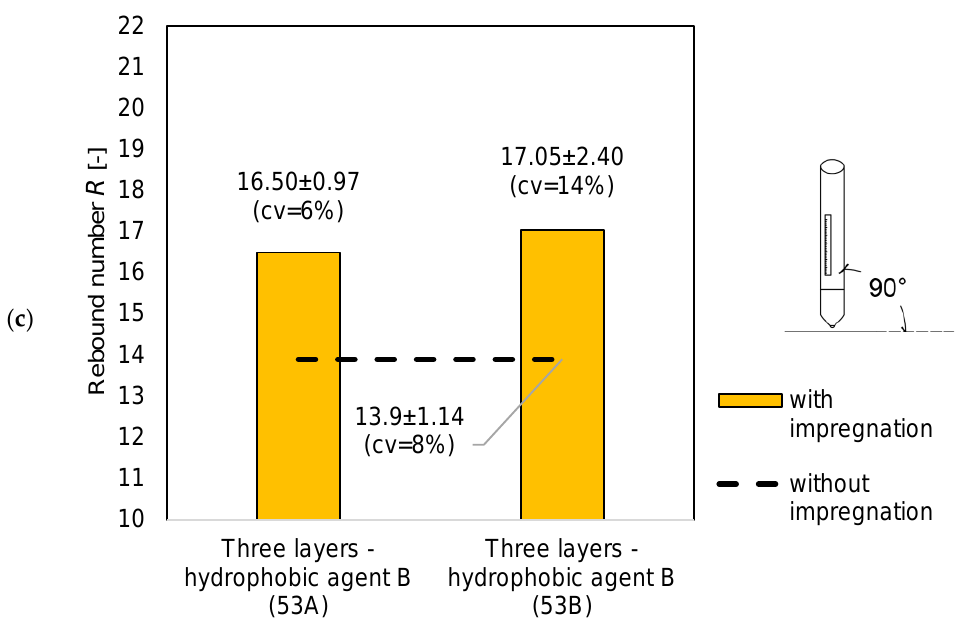
Figure 4. Comparison of the average rebound number for the samples with w/c = 0.5: ( a ) without impregnation and with one layer of the hydrophobic agent; ( b ) without impregnation and with two layers of the hydrophobic agent; and ( c ) without impregnation and with three layers of the hydrophobic agent.